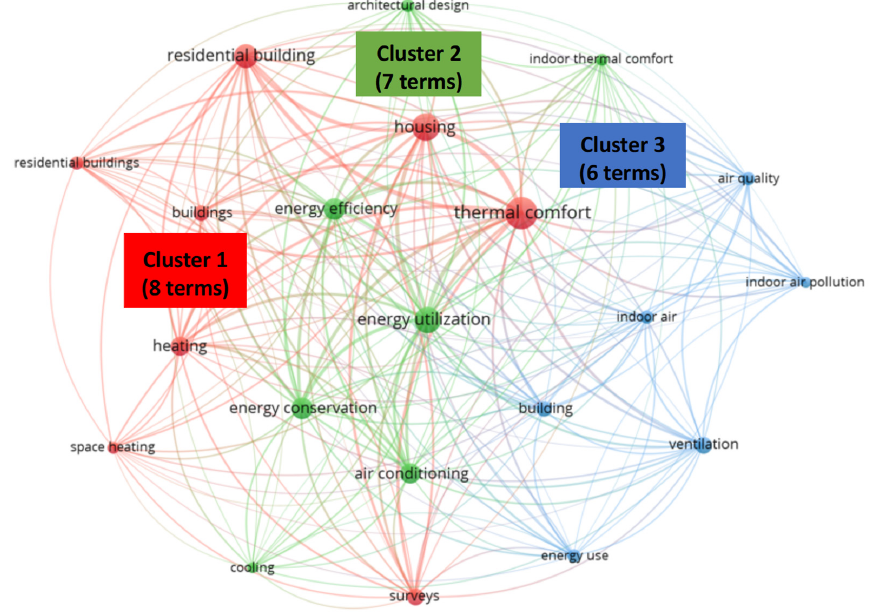
Figure 4. Network visualization by VOSviewer (Clusters of the keywords co-occurrences).